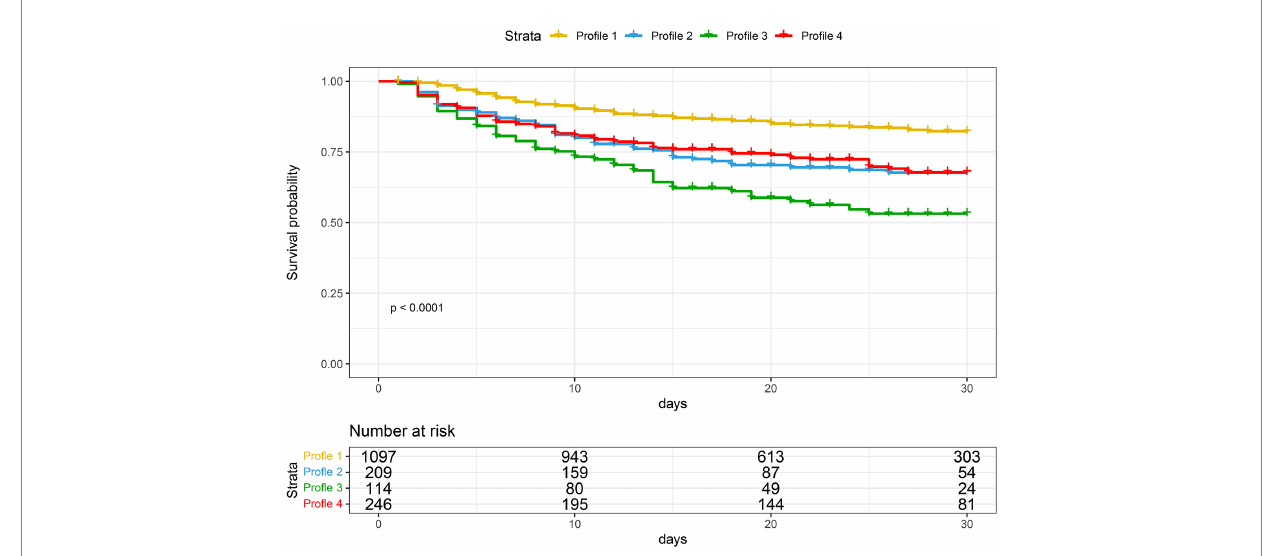
FIGURE 4 Kaplan–Meier curves for 30-day survival, stratified by four subphenotypes.